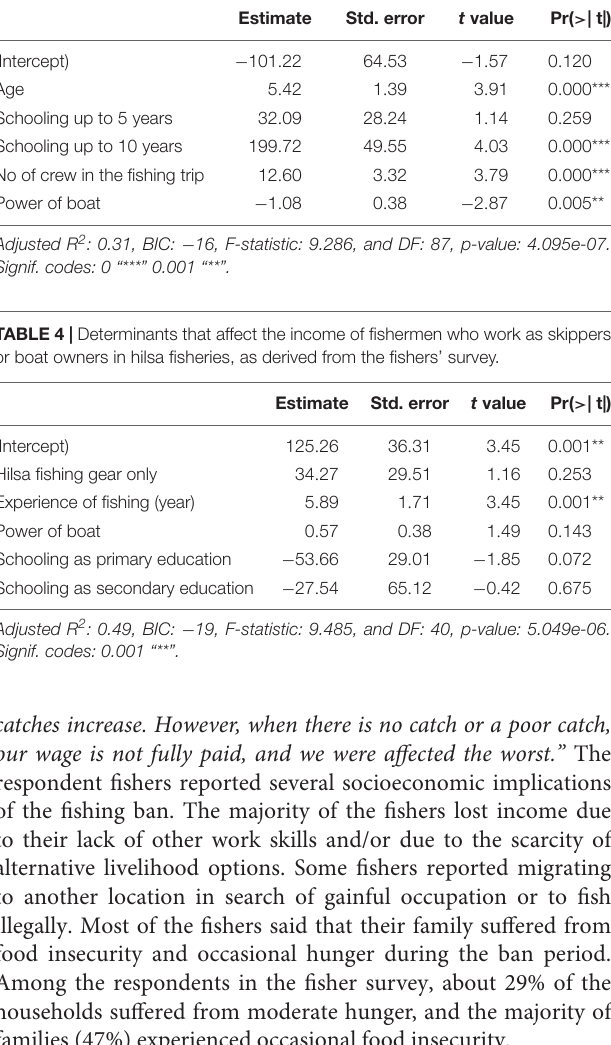
TABLE 3 | Determinants that affect the income of fishermen who work as crew in hilsa fisheries, as obtained from the fishers’ survey. Estimate Std. error t value